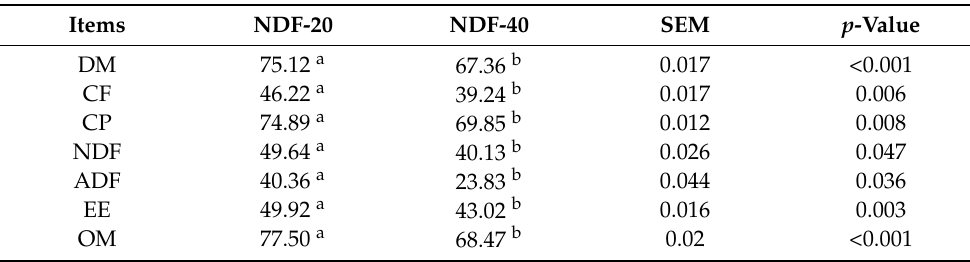
Table 8. Effect of different dietary fiber levels on the digestibility of nutrients in Diqing Tibetan pigs, %.